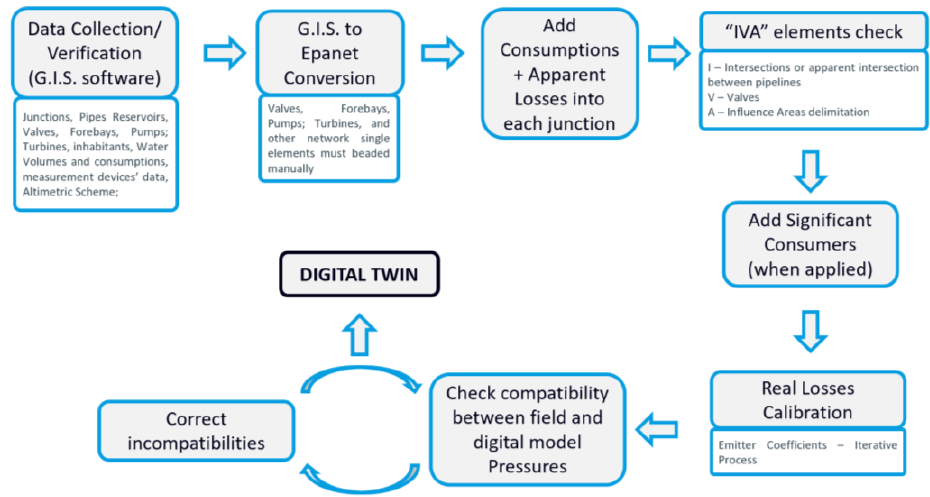
Figure 3. Methodology of the digital twin (DT) model